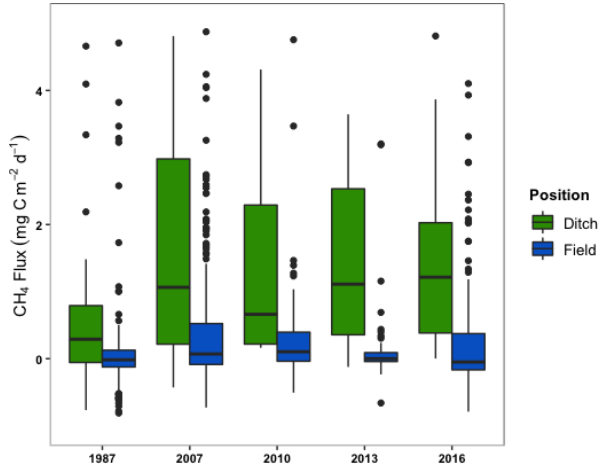
Figure 7. Box and whisker plots of the CH 4 flux by measurement distance from the ditch within each age